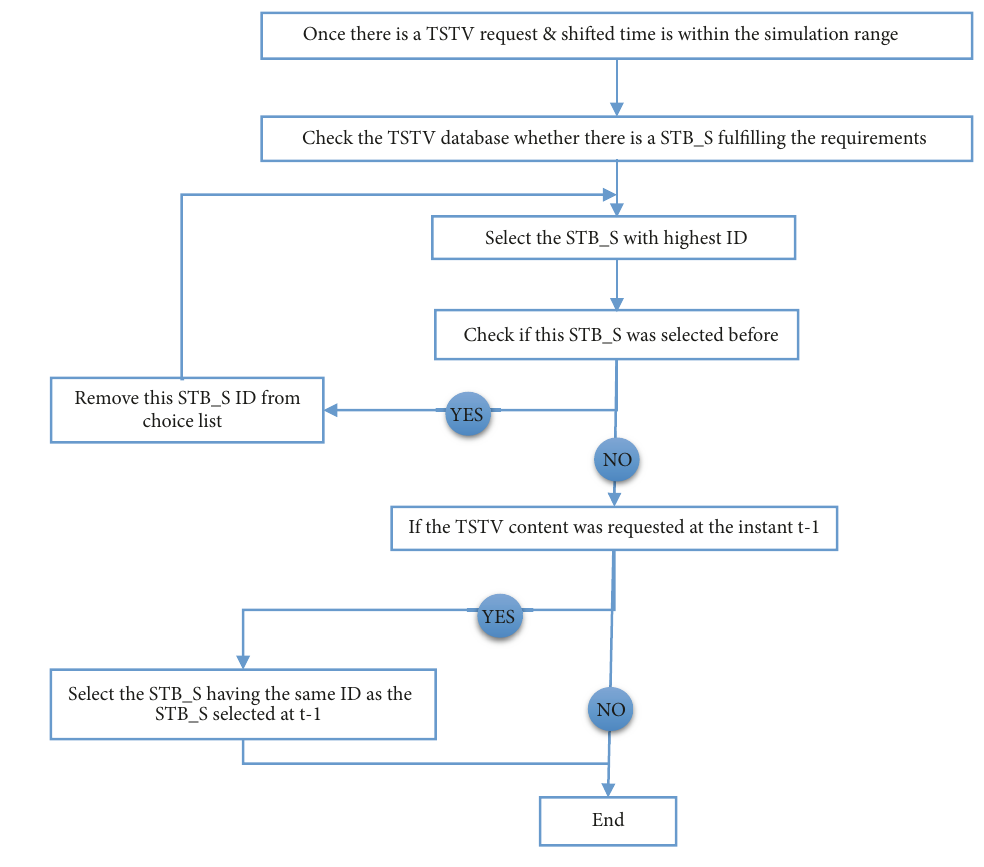
Figure 10: STB S selection